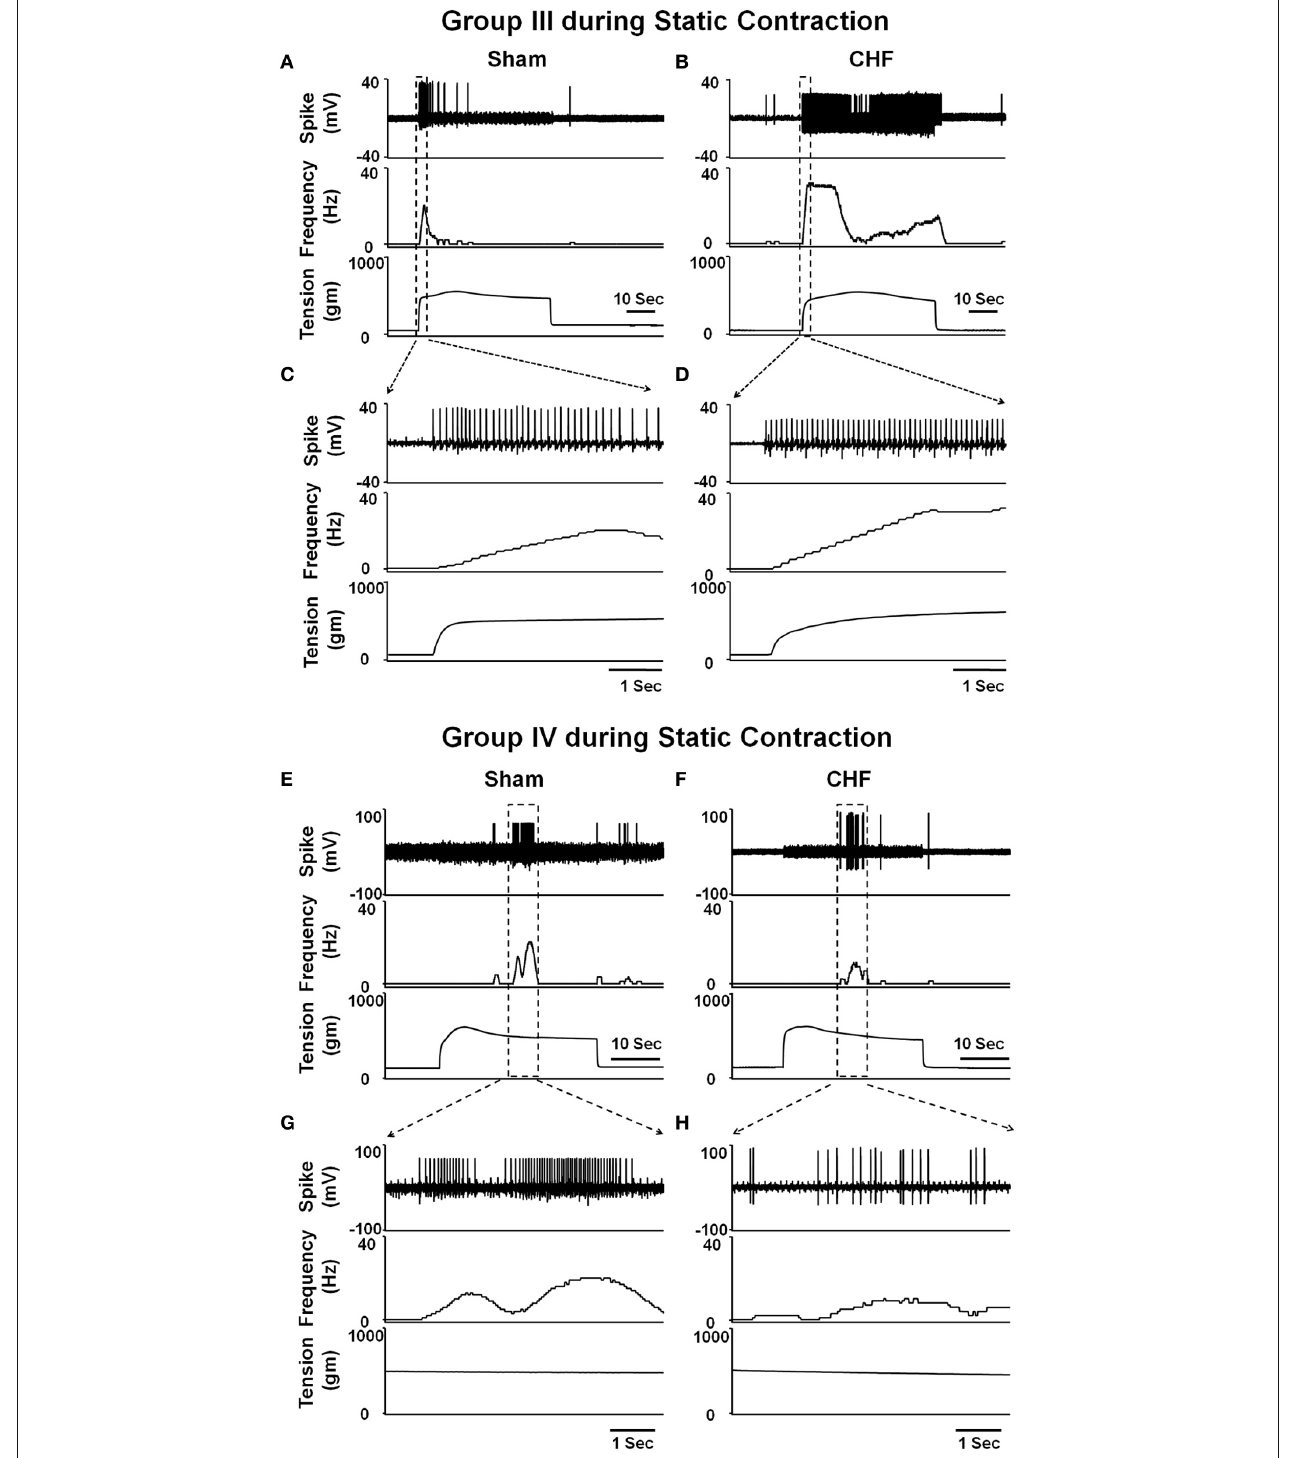
FIGURE 2 | Representative recordings showing the discharge of group III (A–D) and IV (E–H) afferents in response to static contraction induced by electrical stimulation of L5 ventral root in sham (Group III in panel (A): CV, 5.2m/s; Group IV in panel (E): CV, 0.8m/s) and CHF rats (Group III in panel (B): CV, 7.0m/s; Group IV in panel (F): CV, 0.5m/s). (C) and (D) , 5-s